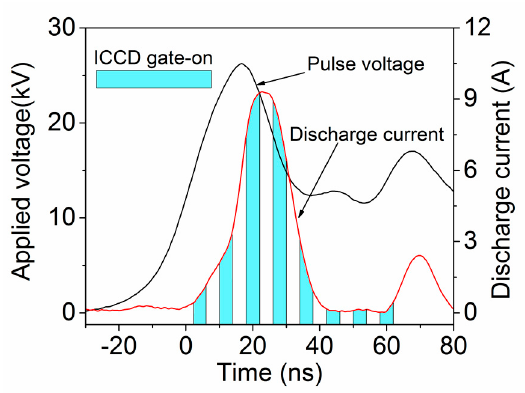
Figure 3. The waveforms of nanosecond pulsed voltage and discharge current.